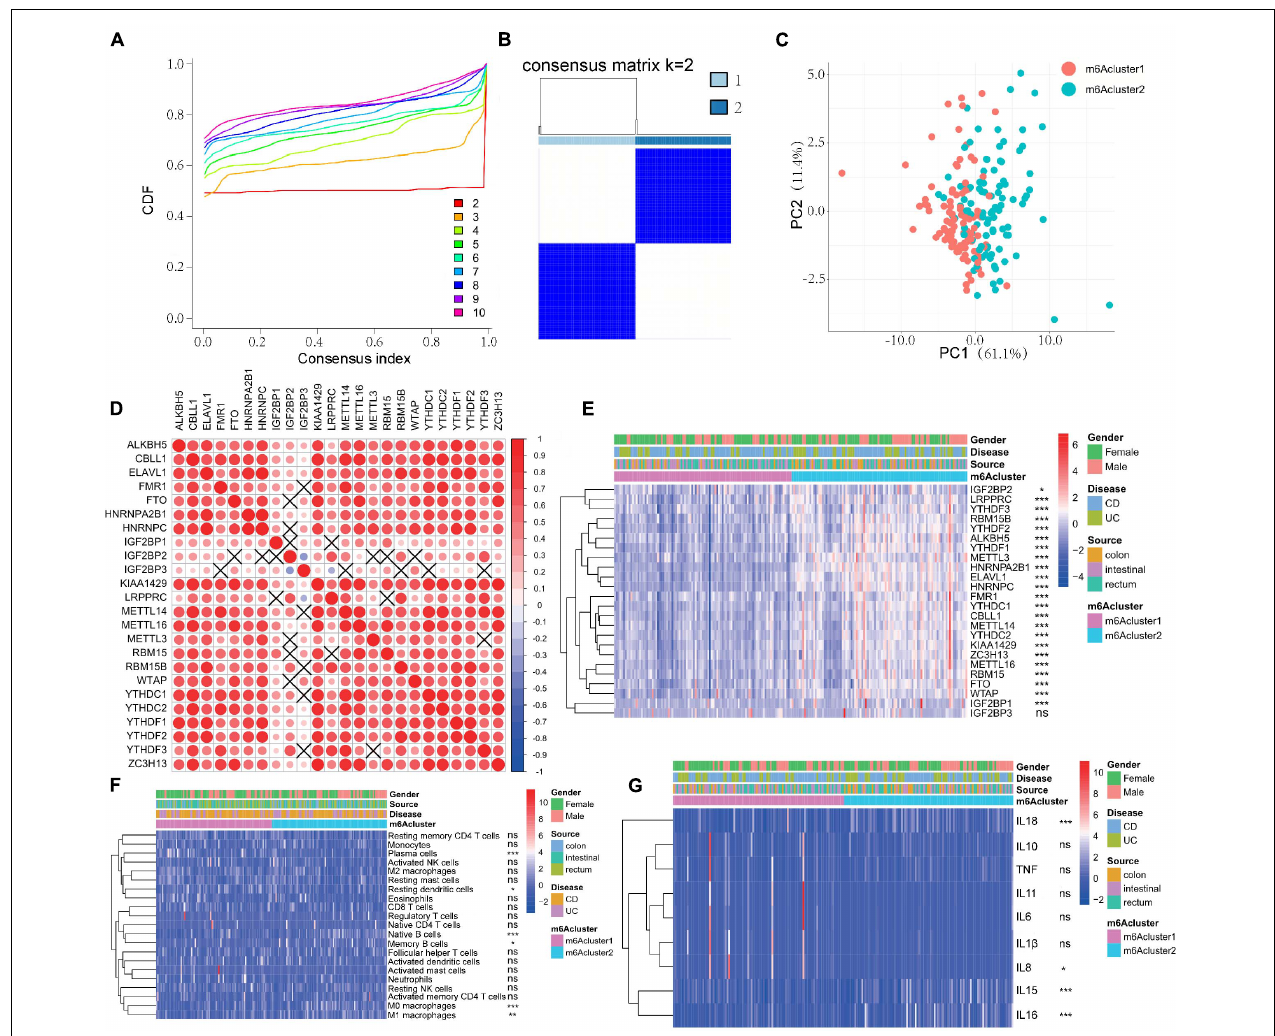
FIGURE 2 | m 6 A methylation modification patterns are correlated with the clinical characteristics and the mucosal immune microenvironment in IBD. (A–C) Consensus clustering identified two subgroups according to the expression of m 6 A regulators. (D) Evaluation the pairwise correlations among 24 m 6 A regulators’ expression. (E) The expression of 24 m 6 A regulators in different m 6 A subtypes and disease subtypes. (F,G) The difference of mucosal immune cells infiltration panel (F) and inflammatory factors panel (G) between m 6 Acluster1 and m 6 Acluster2. The asterisks represented the statistical P -value (* P < 0.05; ** P < 0.01; *** P < 0.001).